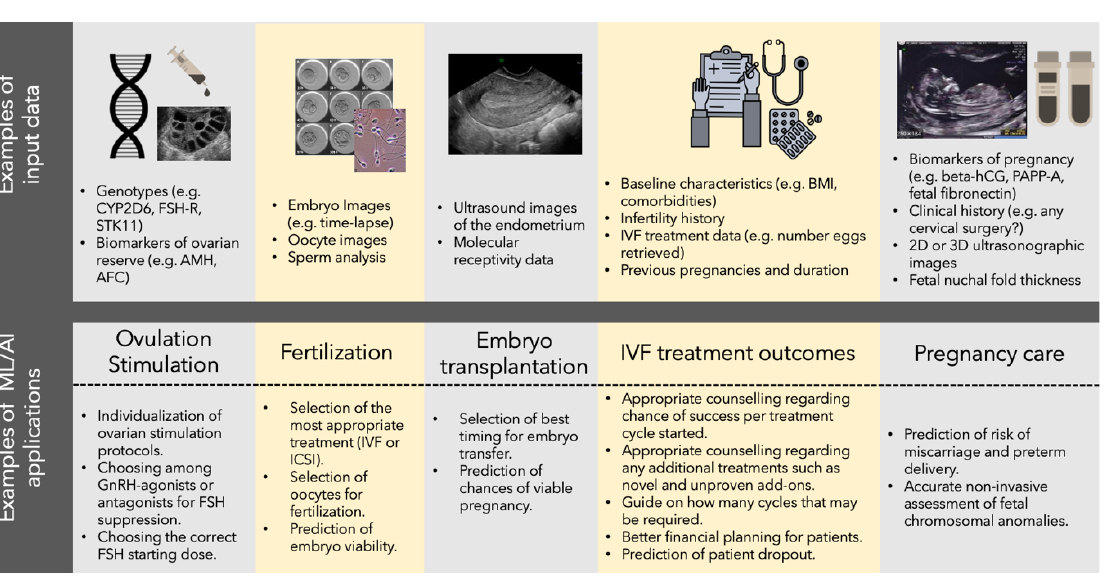
Figure 3. Examples of different types of input data and ML models that can be built and applied to improving ART treatments.